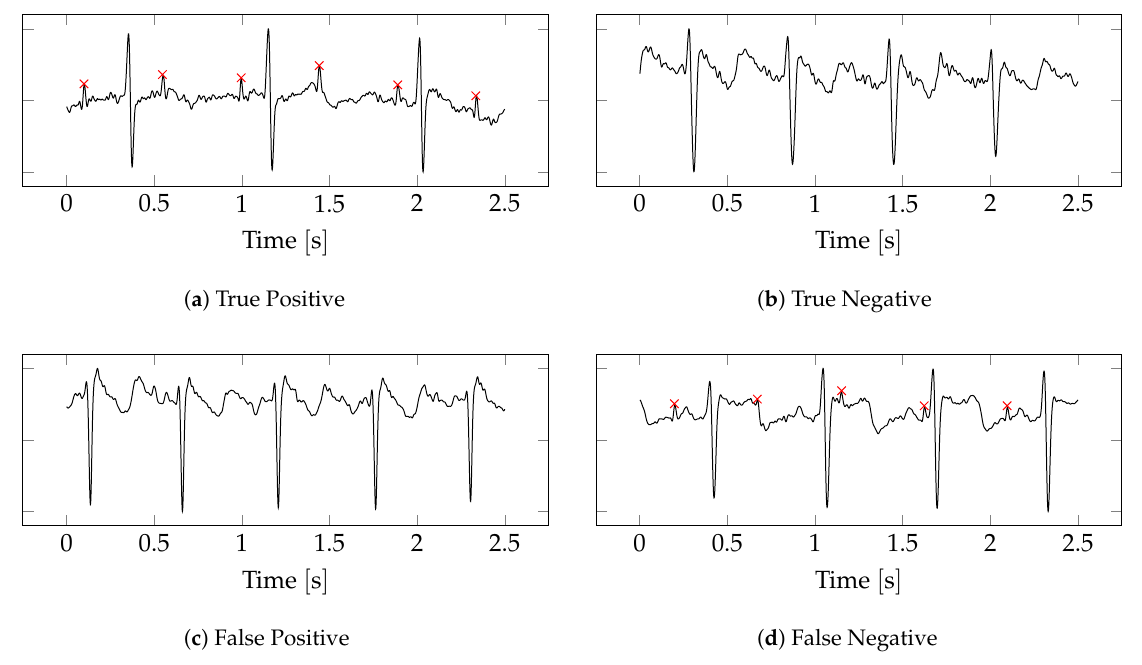
Figure 8. Examples of true and false predictions. Only the first abdominal channel is shown. The ground truth foetal R peaks are labelled with a red